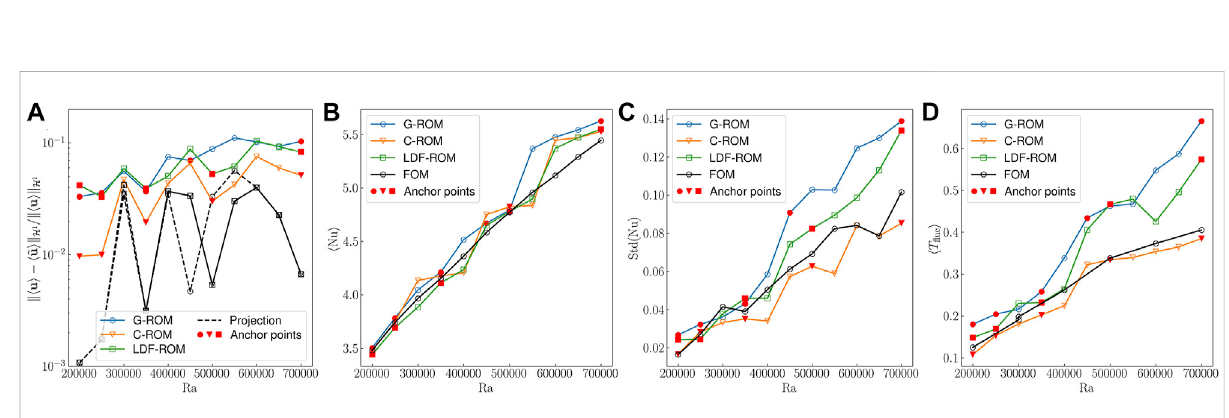
FIGURE 8 POD- h Greedy performance comparison between G-ROM, C-ROM and LDF ROM for the parametric problem parameterized with Ra at – D) Behavior of the relative H 1 error in predicted mean fl ow, predicted mean Nu, Std(Nu) and mean temperature θ g = 90 ° and Pr = 7.2. (A fl uctuation based on fi ve anchor points. ( N = 80, Ra p